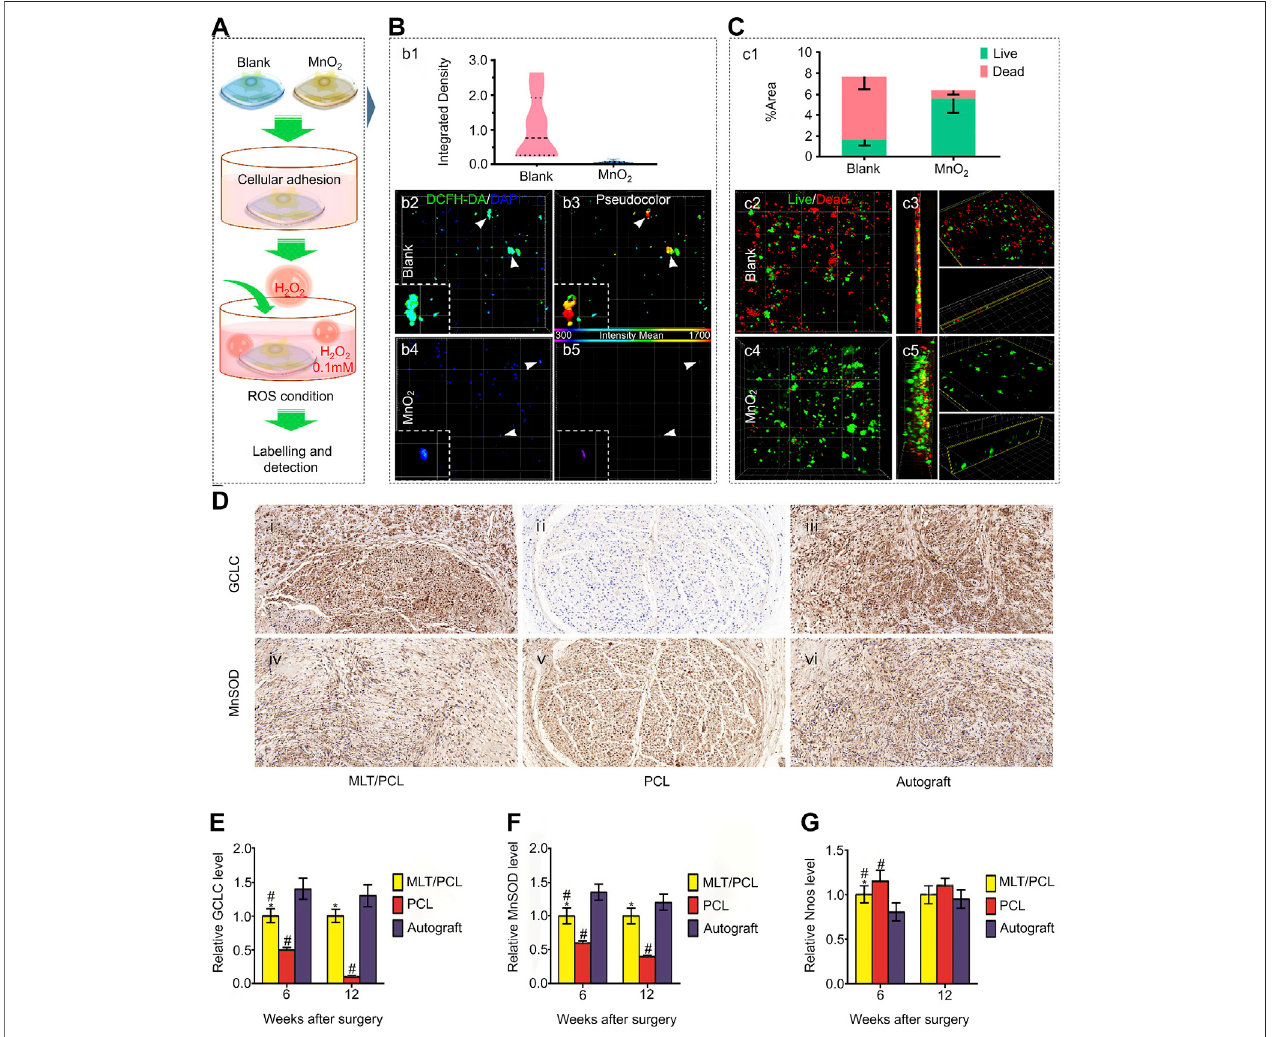
FIGURE8| Biomaterialsreversetheadverseimmunemicroenvironmentbyremovingharmfulcomponentsfromtheextracellularmatrix. (A) Simulatethecultivation ofMSCsinamicroenvironmentcontainingROS. (B) Afterlabelingwithdichlorodihydro fl uoresceindiacetate(DCFH-DA),quantify(b1)intracellularROSlevelsinblank(b2, b3) and MnO2 NP points (b4, b5) hydrogels. (C) Use live/dead assay to analyze cell survival in the blank group (c2, c3) and treatment group (c4, c5), and quantify the stainedarea(c1). (D) OxidativestressassessmentofMLT/PCLandPCLcathetersaftersurgery. (E) RelativelevelofGCLC. (F) RelativelevelofMnSOD. (G) Relative level of nNOS. Reproduced with permission from (139,